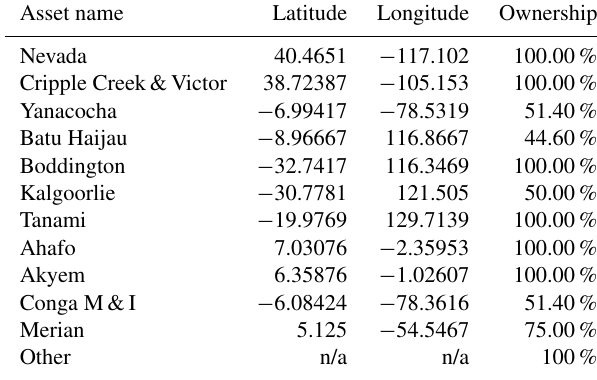
Table A6. Mining assets valued in TD Securities (2016b) for Newmont